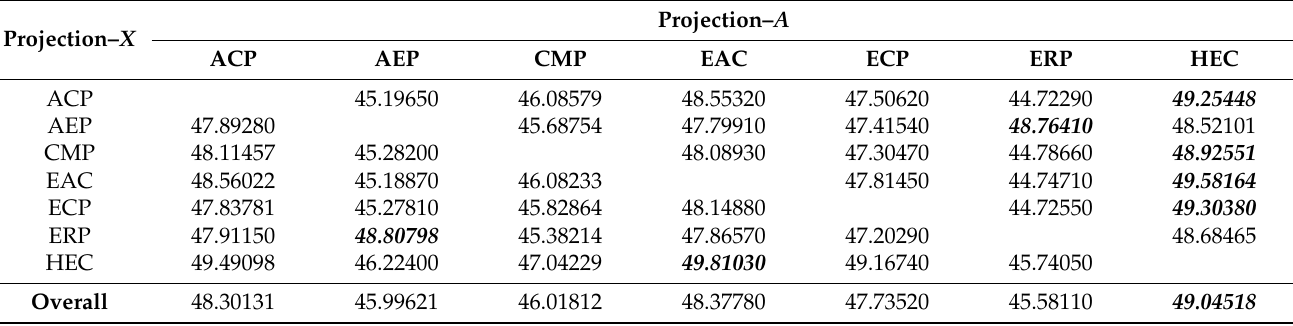
Table 1. Comparison using PSNR (average values at 2K, 4K, and